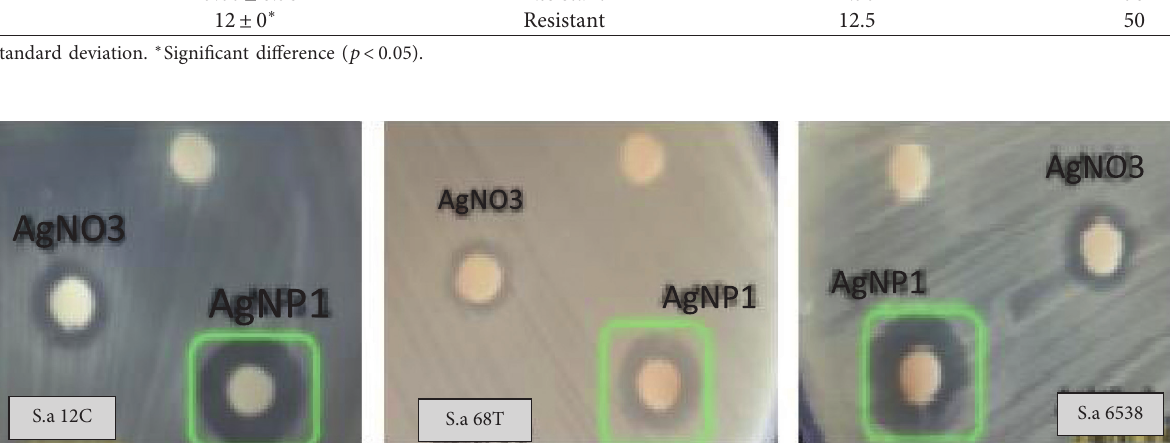
3 ) using dried peel orange